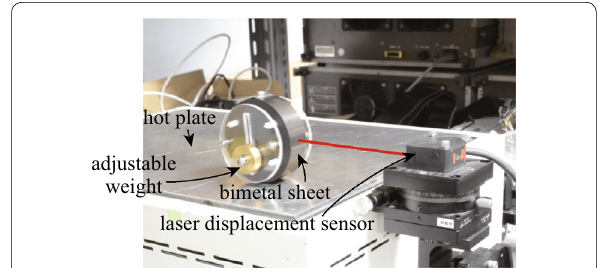
Fig. 8 Setup for amplitude measurement using two different cylinders. A cylinder with a bimetal sheet was placed on a hot surface heated at 100 °C. Its displacement was measured by a laser displacement sensor from the side for 200 s